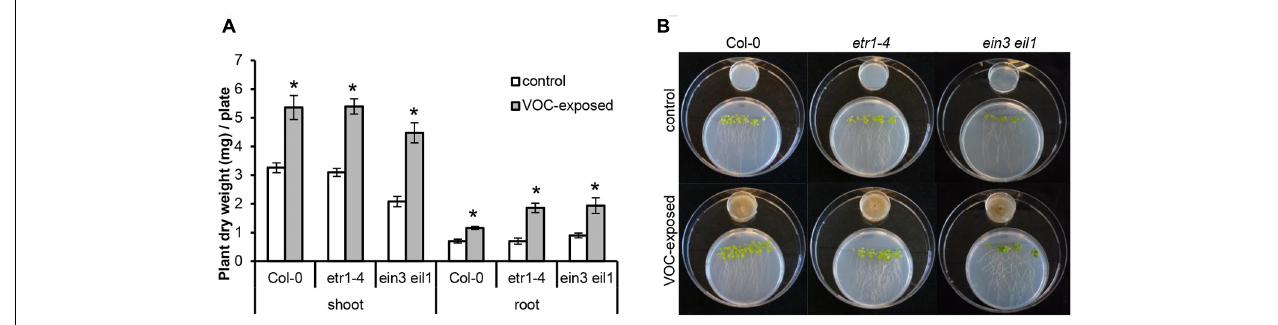
FIGURE 3 | Effects of volatile organic compounds (VOCs) from R. solani on the growth of ethylene-insensitive mutants of A. thaliana . (A) Shoot and root biomass (mean ± SE, n = 4–5) of A. thaliana wild-type Col-0 and mutants etr1-4 and ein3 eil1 exposed to VOCs from R. solani . Each replicate consists of one Petri dish with six seedlings. Asterisks indicate a statistically significant difference between VOC-exposed and control (exposed to agar medium only) plants (Student’s t -test, P < 0.05). (B) Phenotype of A. thaliana wild-type and mutants after 14 days of exposure to the fungal VOCs. TABLE 1 | Volatile organic compounds (VOCs) emitted by the fungal pathogen Rhizoctonia solani . VOCs displayed are significantly different (Student’s t -test, P < 0.05, n = 3), being at least twice as abundant as in the control (medium only). Compounds were identified by comparing their mass spectra and LRI with those of